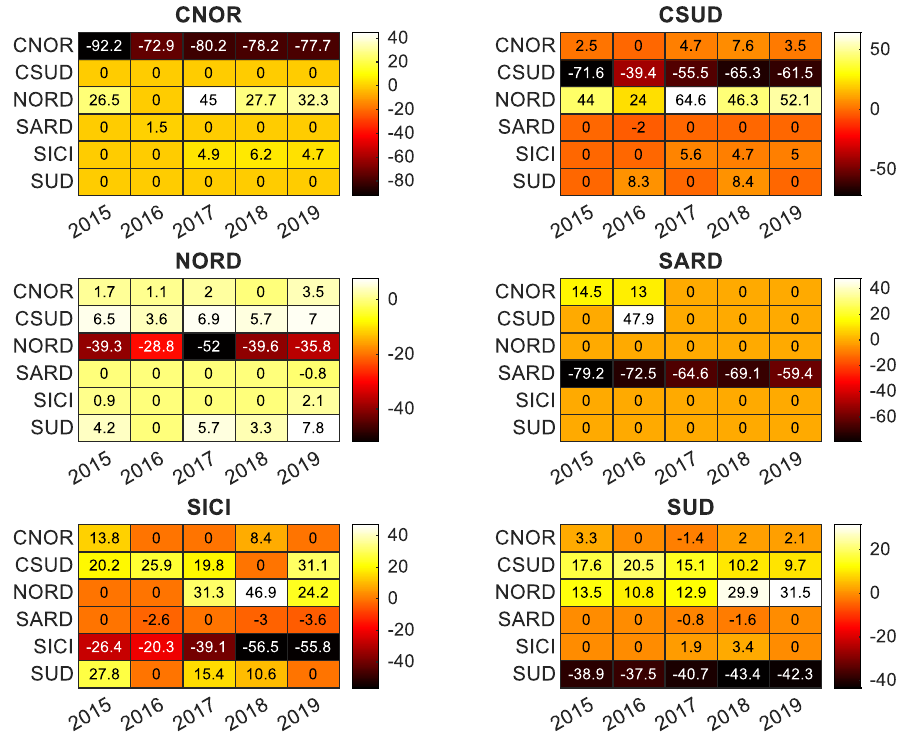
Figure A2. Heatmap chart of the impact of 100 MWh increases in solar generation on the net input flow (MW); results of Equations (1) and (2). Table A13. OLS estimation of daily changes in electricity prices of CNOR; results of Equation (3).